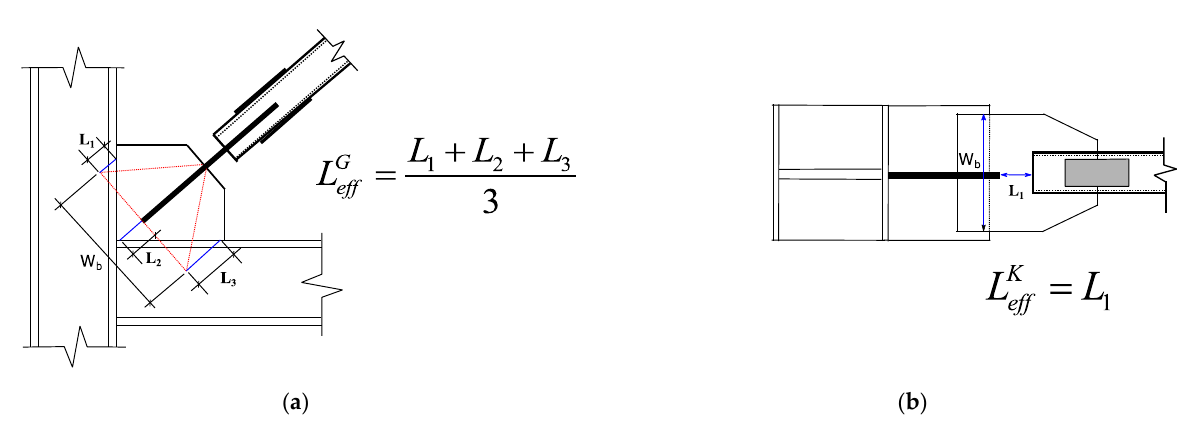
Figure 3. Illustration of Whitmore effective width and effective buckling length in ( a ) gusset plate and ( b ) knife plate of the IPB braced